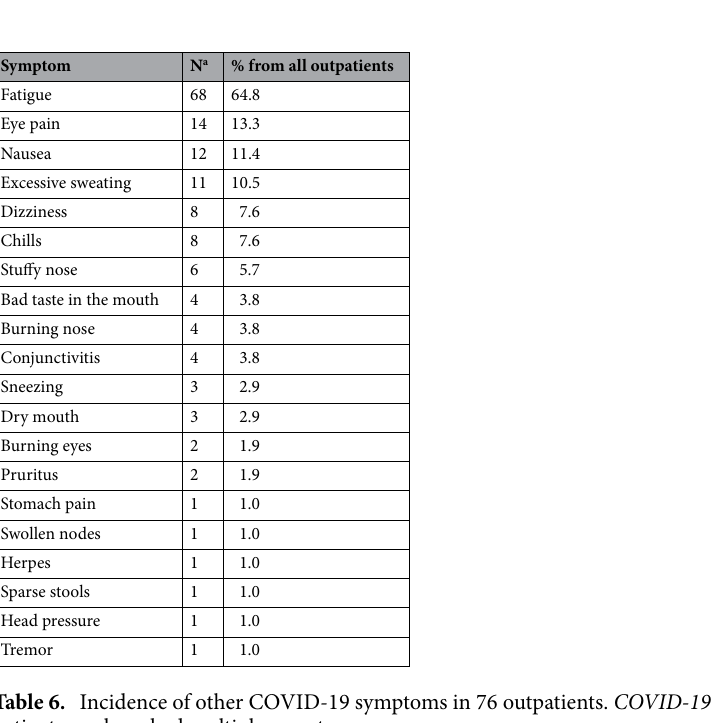
Table 6. Incidence of other COVID-19 symptoms in 76 outpatients. COVID‑19 coronavirus disease-19. a One patient may have had multiple